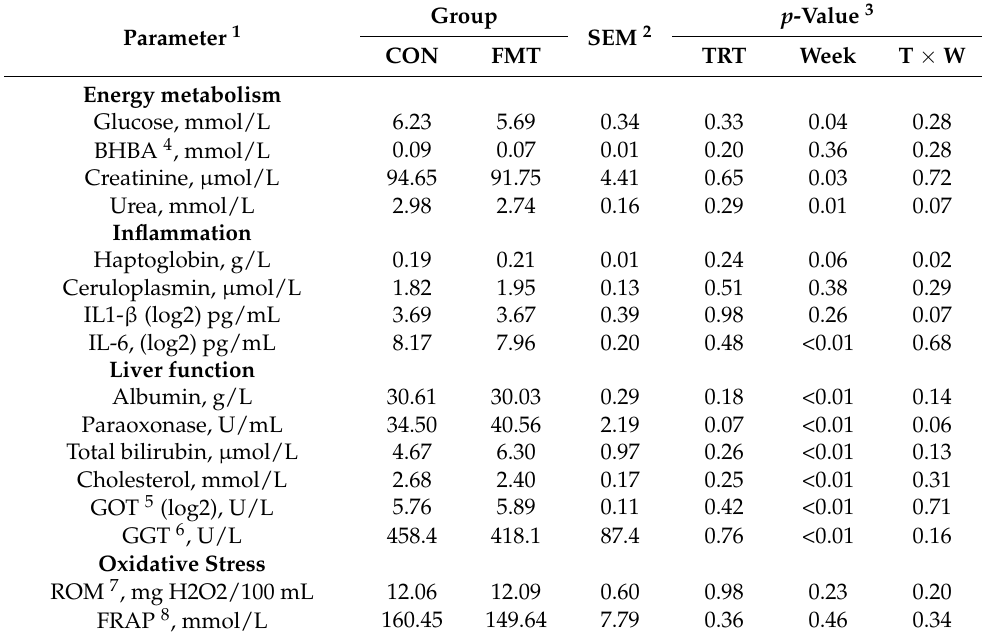
Table 3. Blood immunometabolic biomarkers during the neonatal period (from birth to 3 weeks of age) in Holstein dairy calves raised under a conventional nutritional program (CON) or subjected to fecal microbiota transplantation